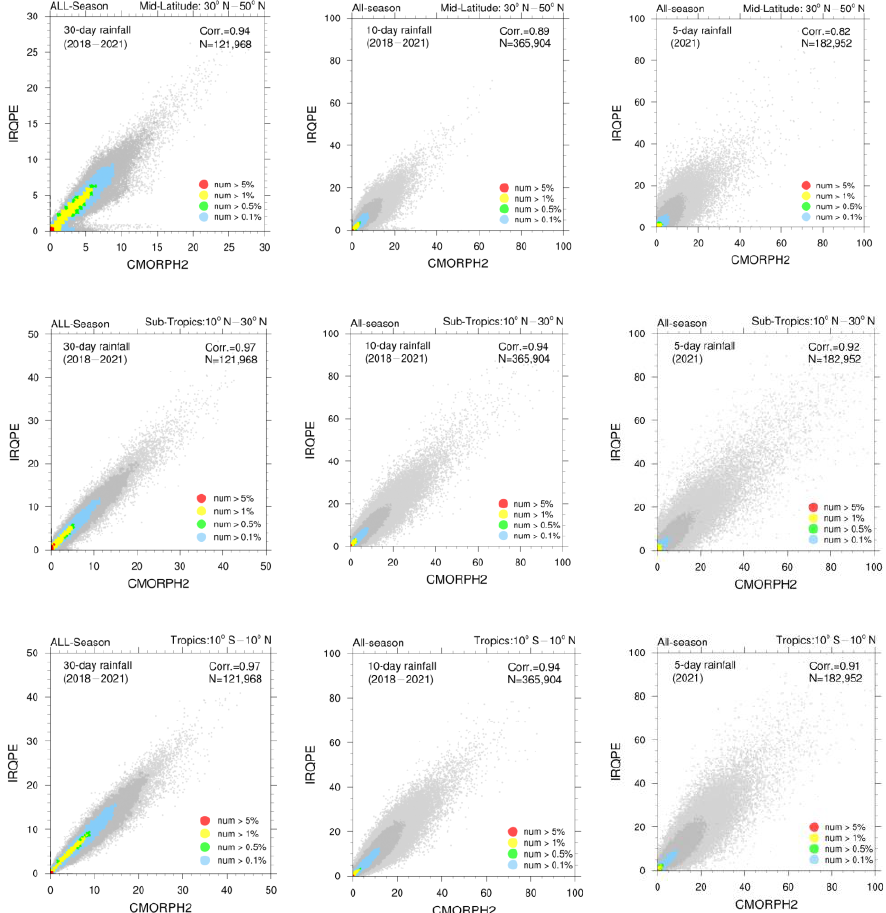
Figure 4. The point-to-point scatter plot for IRQPE and CMORPH2 over 80° E – 160° W in 3 latitudinal bands: From left to right: 30-day rainfall, 10-day rainfall, 5-day rainfall. From top to bottom: mid- latitude (30° N – 50° N), sub-tropic (10° N – 30° N), tropics (10° S – 10° N).